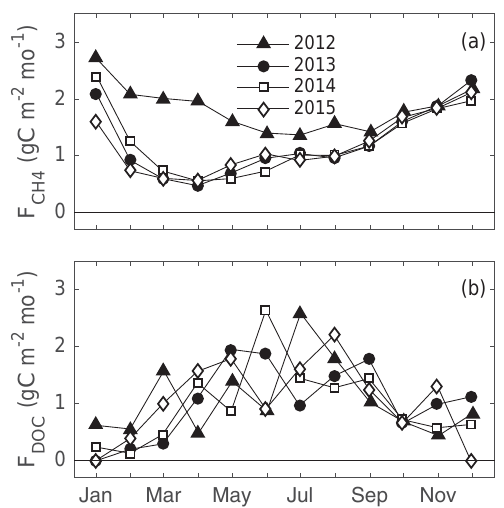
Figure 3. Monthly total non-CO 2 –C flux components at Kopuatai bog over the 4 measurement years. (a) Methane flux ( F CH solved organic carbon export ( F DOC